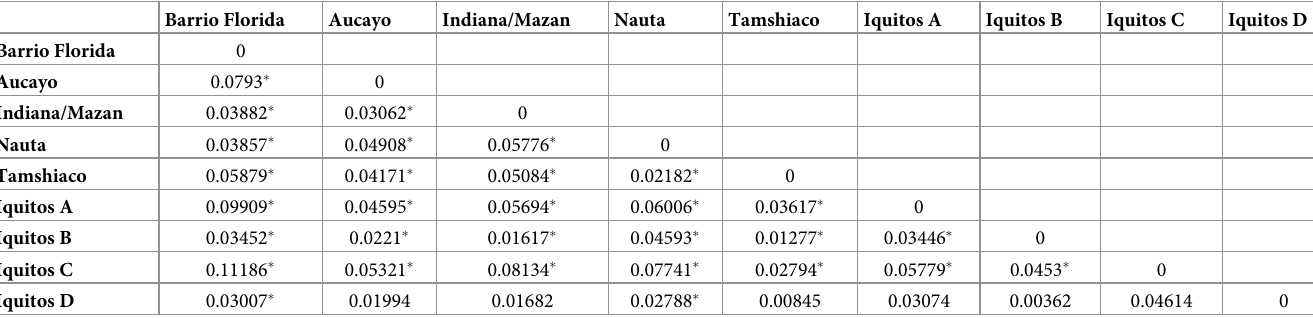
Table 3. Pairwise F ST values between 9 sampling